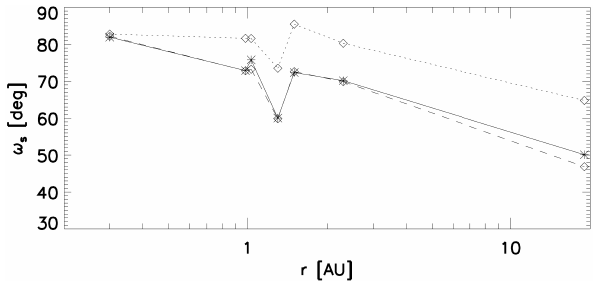
Fig. 14. Radial dependences of the mean thickness h d km i for the overall distribution; the mean error is shown by error